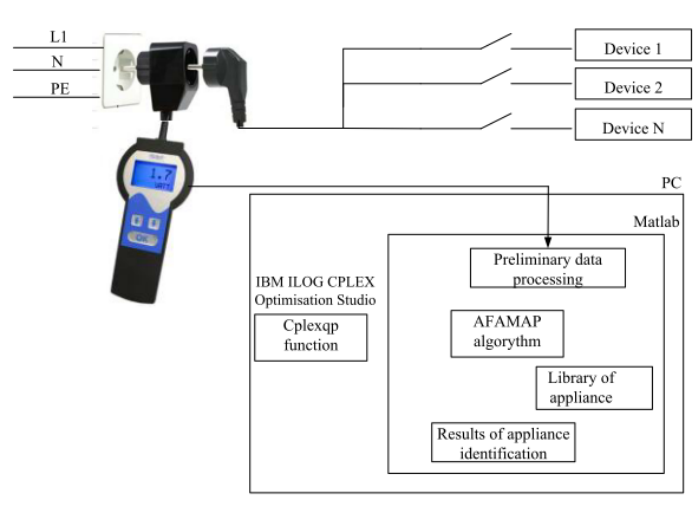
Figure 12. Low-frequency NIALM architecture [52].